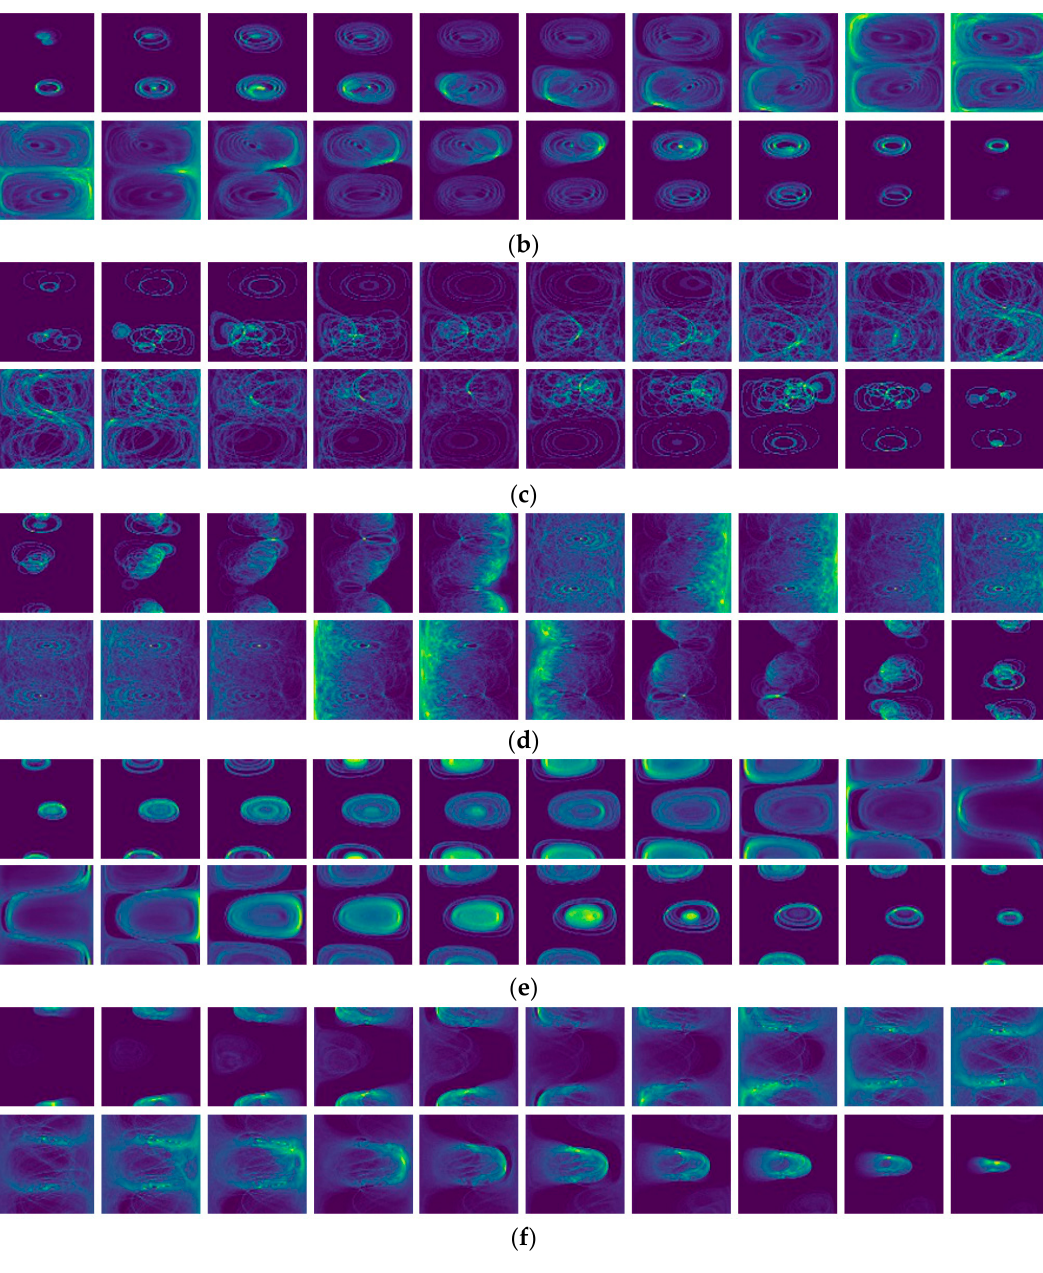
Figure 6. The 3D Hough spaces mapped from 6 samples of different objects: ( a ) pole, ( b ) pedestrian, ( c ) tree, ( d ) bush, ( e ) building, ( f ) vehicle.